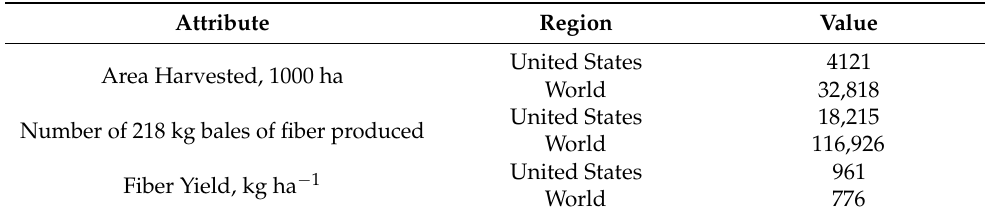
Table A1. Area harvested, fiber production, and yield for the five-year average of crop years 2016 to 2020 [50].